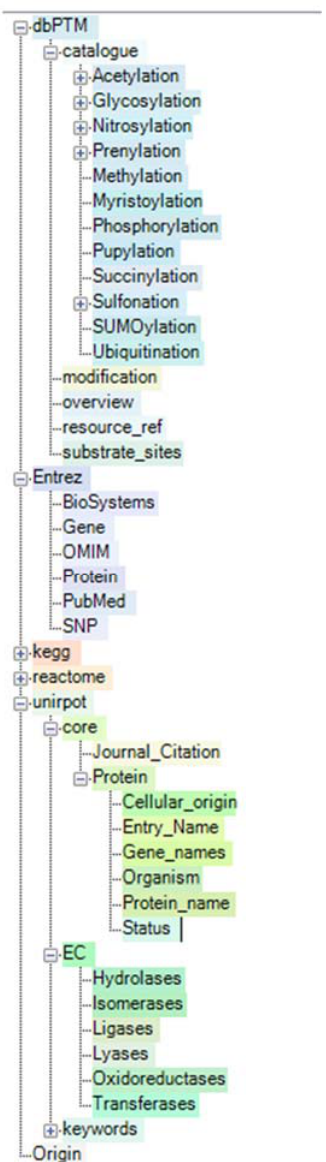
Figure 2. Databases, with their partially extended ontological class trees, whose content was searched via Semantic Protocol and RDF Query Language (SPARQL) using Knowledge Explorer (KE) [34,40]. Retrieved results were imported, harmonized and mapped to this ontology to create a Semantic Knowledge Base.